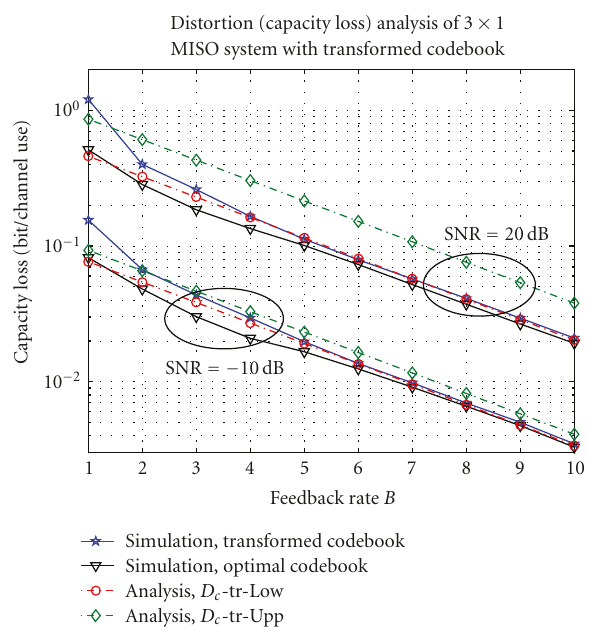
Figure 2: Capacity loss of a 3 × 1 correlated MISO system with normalized antenna spacing d = D/λ = 0 . 5 versus CSI feedback rate B using di ff erent channel quantization codebooks (optimal codebook versus transformed